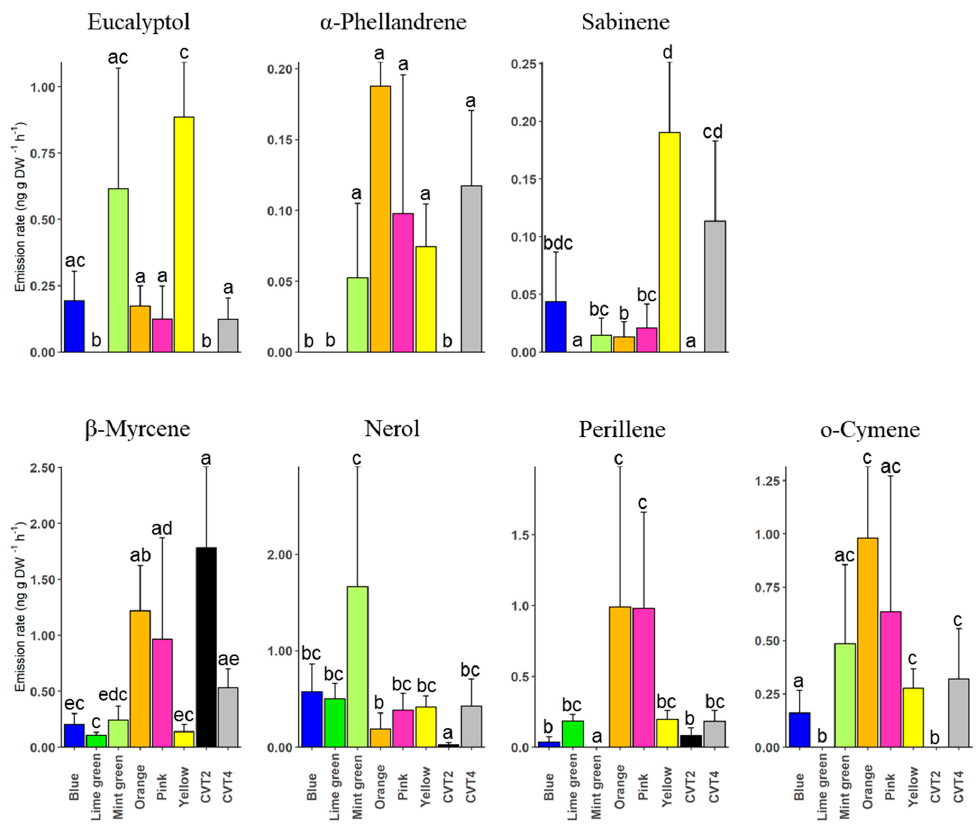
Figure 5. Emission rates for selected monoterpenoids by different genotypes ( n = 5). Compounds were selected based on their VIP coefficients ( ≥ 1). A set of level contrasts was constructed using the “relevel” function in R. Bars show mean ± SE emissions, and different letters show significant differences between genotypes.